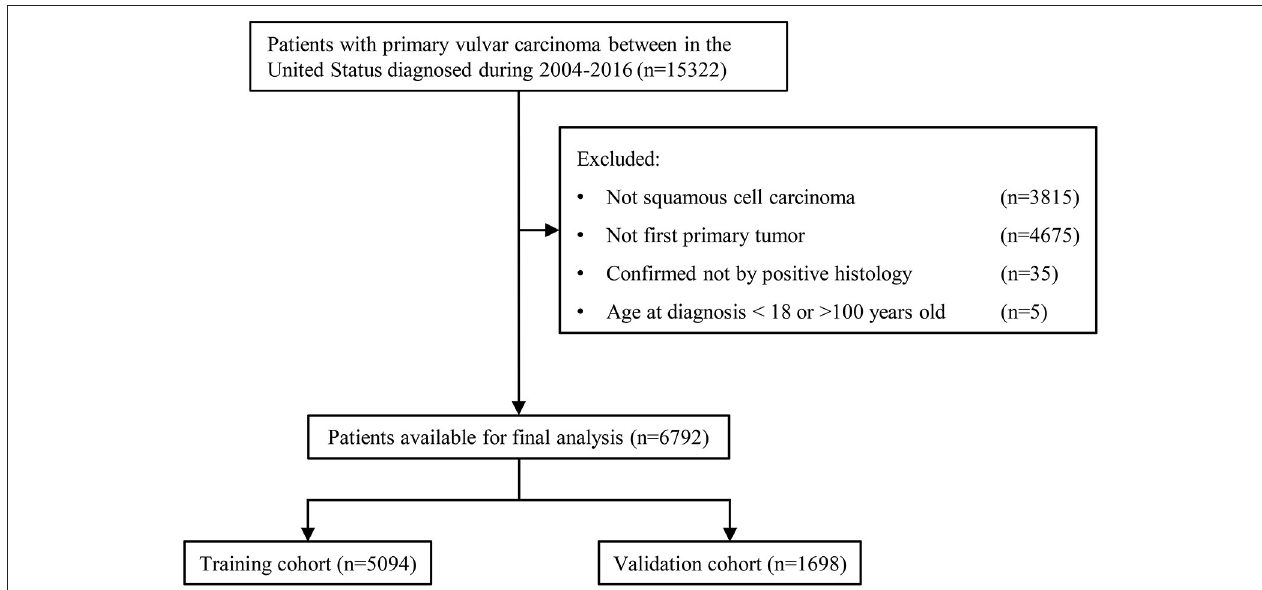
FIGURE 1 | Flowchart of the patient selection